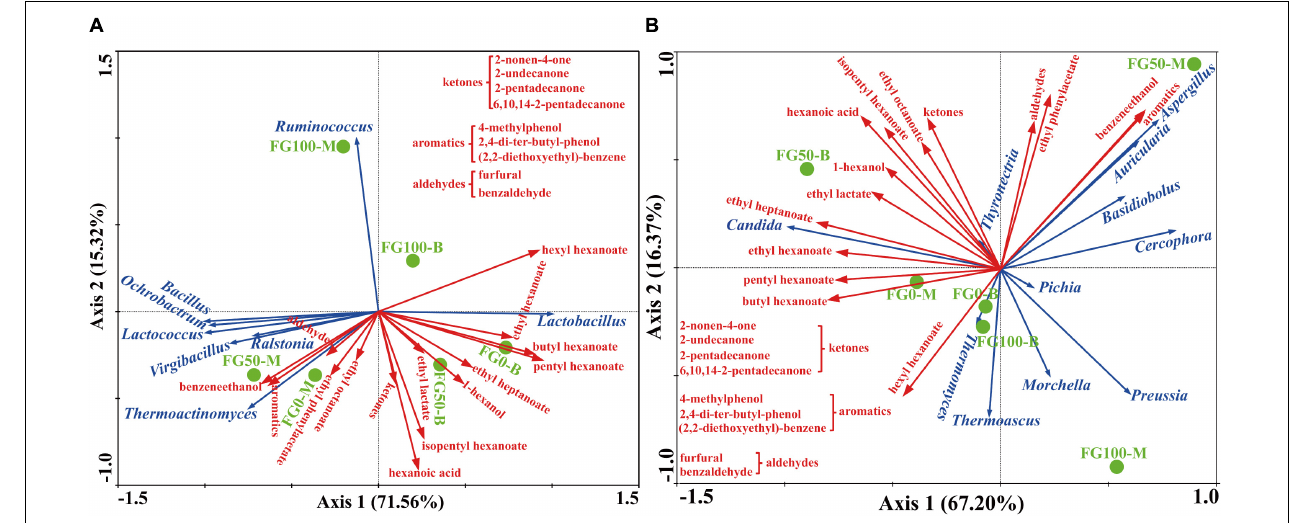
FIGURE 6 | Correlation of prokaryotic (A) and eukaryotic (B) communities with flavor compounds by redundancy analysis.